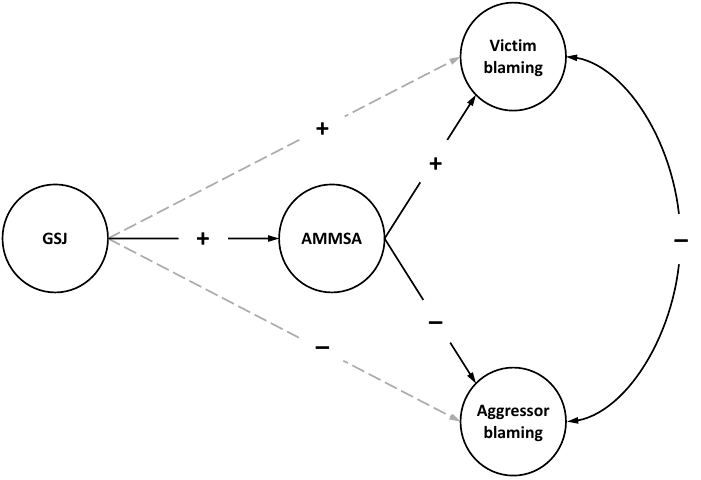
Figure 1. Hypothesized model of rape myth